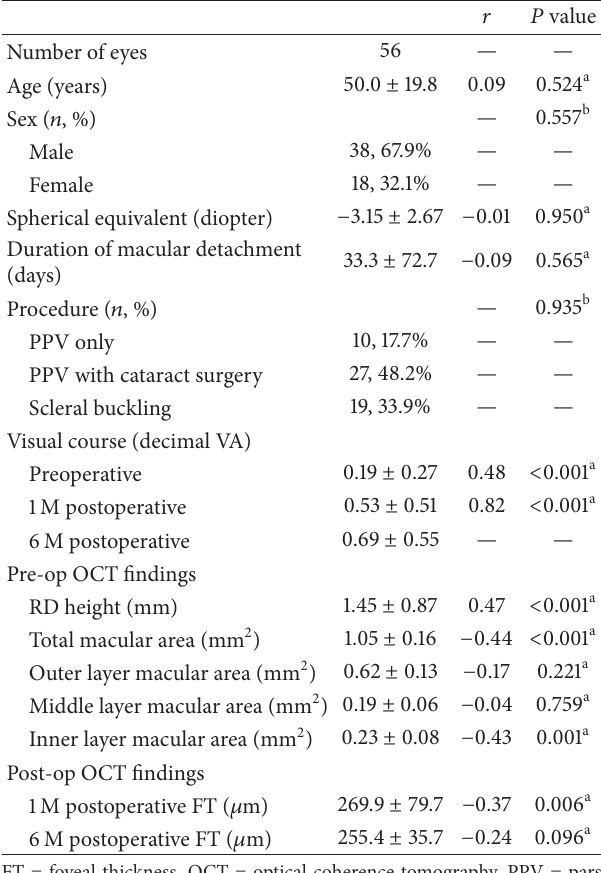
FT = foveal thickness, OCT = optical coherence tomography, PPV = pars plana vitrectomy, RD = retinal detachment, and VA = visual acuity. a Spearman’s correlation coefficient by rank test, b unpaired 𝑡